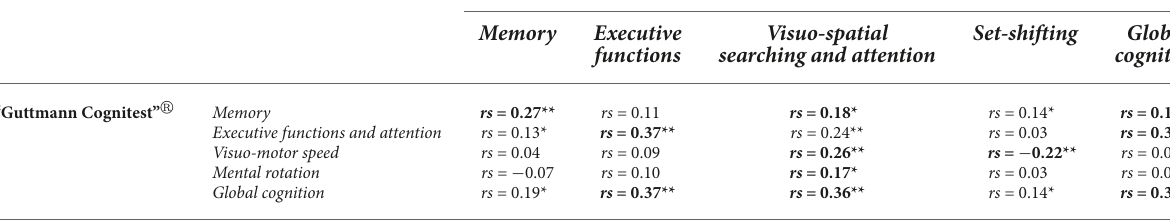
Gold-standard paper and pencil tests